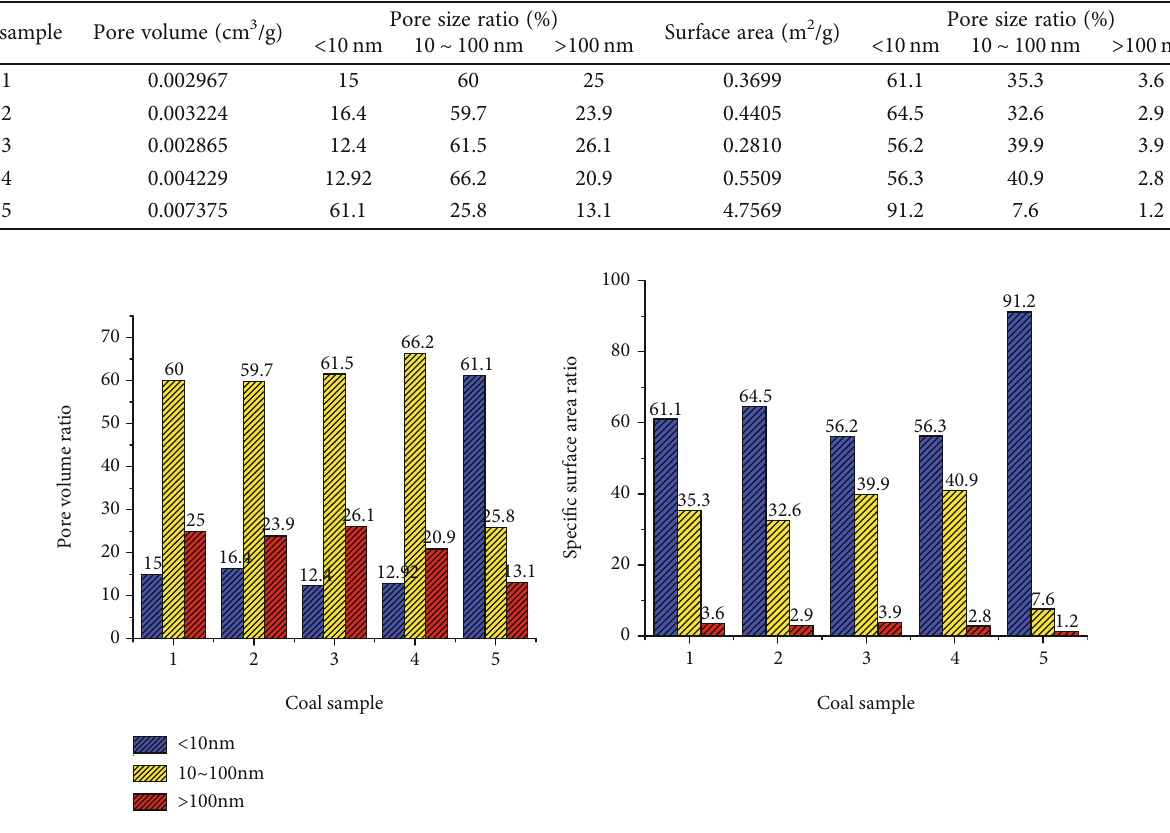
Figure 9: Speci fi c surface area and pore volume ratio of each pore diameter segment of a coal sample.